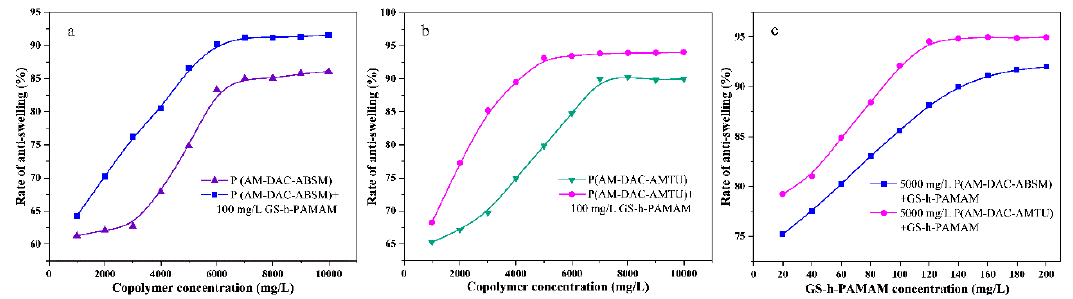
Figure 4. The optimization of supramolecular systems: ( a ) P(AM-DAC-ABSM) concentration; ( b ) P(AM-DAC-ABSM) concentration; ( c ) GS-h-PAMAM concentration.